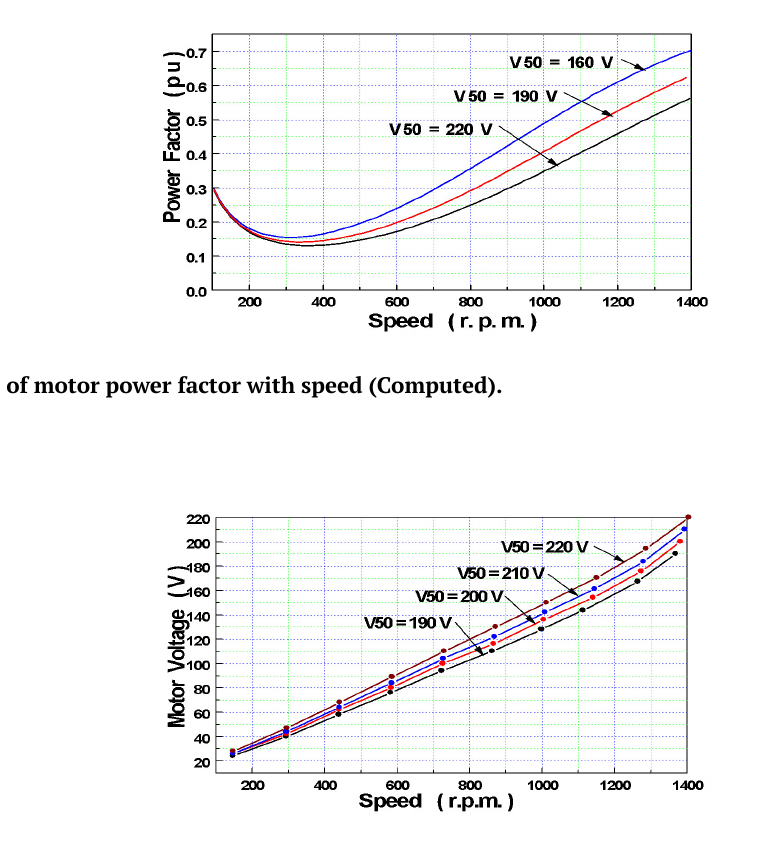
Fig. 10. Variation of motor applied voltage with speed (Experimental).